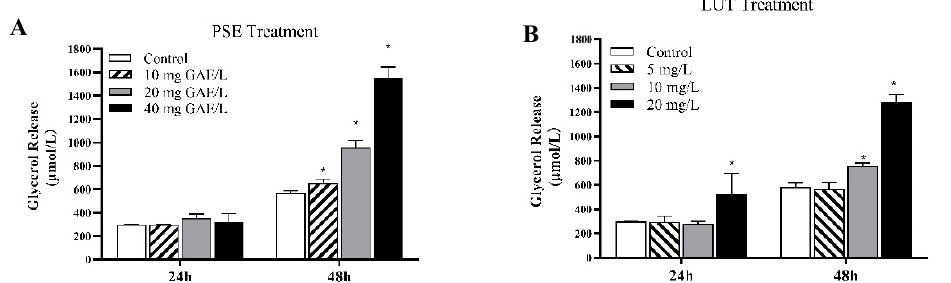
Figure 5. The effect of PSE and LUT on adipocyte lipolysis. Fully differentiated adipocytes treated with various concentrations of ( A ) PSE (0 mg GAE/L, 10 mg GAE/L, 20 mg GAE/L and 40 mg GAE/L) and ( B ) LUT (0 mg/L, 5 mg/L, 10 mg/L and 20 mg/L) for 24 h and 48 h, respectively. The data are presented as the mean ± SD from three independent experiments. * Significant differences are indicated by p < 0.05.